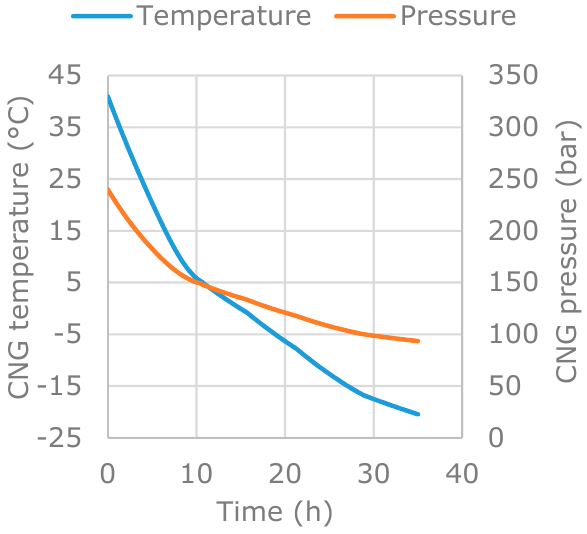
Figure 6. Storage terminal CNG conditions (adiabatic loading).